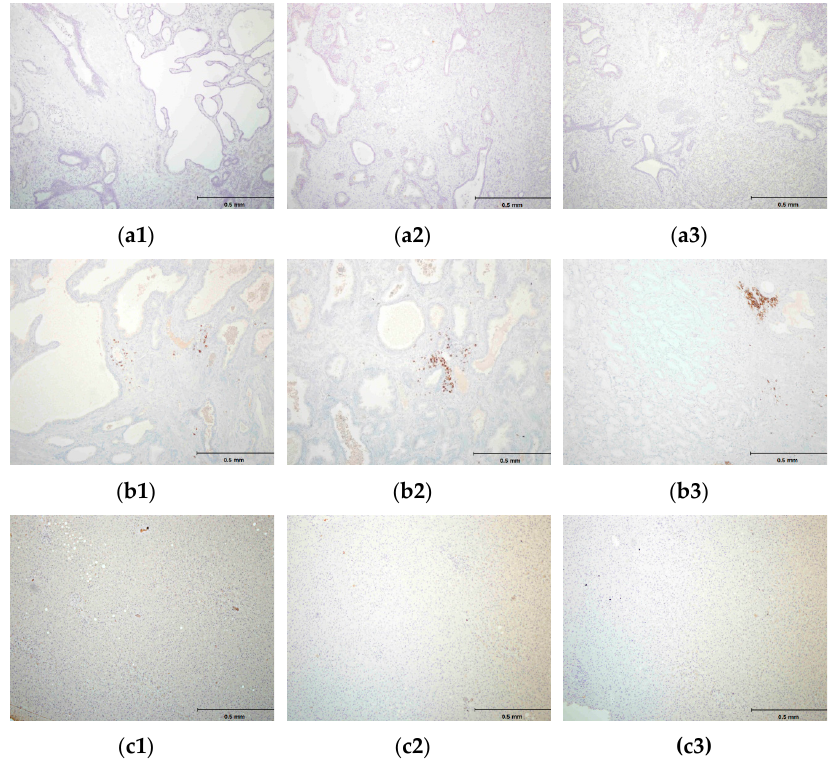
* The column with the largest scores is marked red.